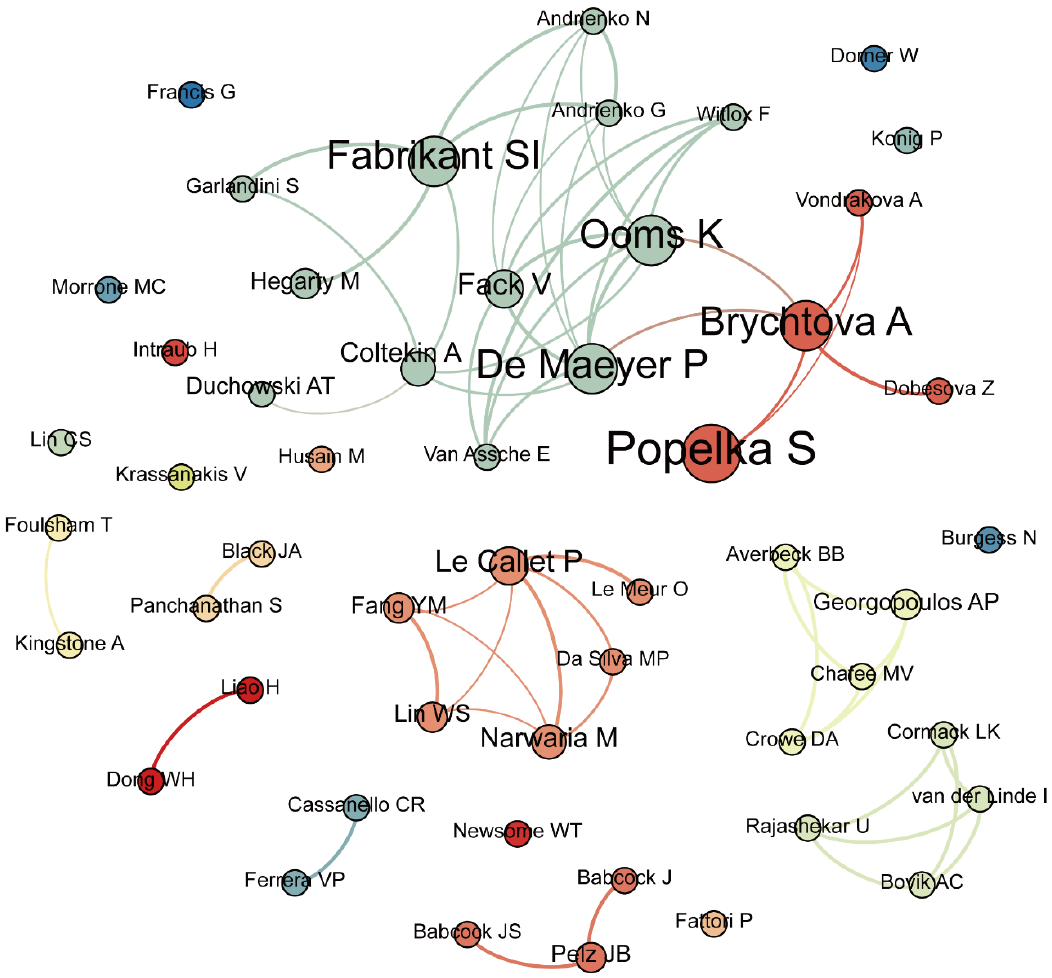
Figure 6. Co-occurrence network of authors (size of the node represents author’s publication quantity). Table 4. Top ranked authors.